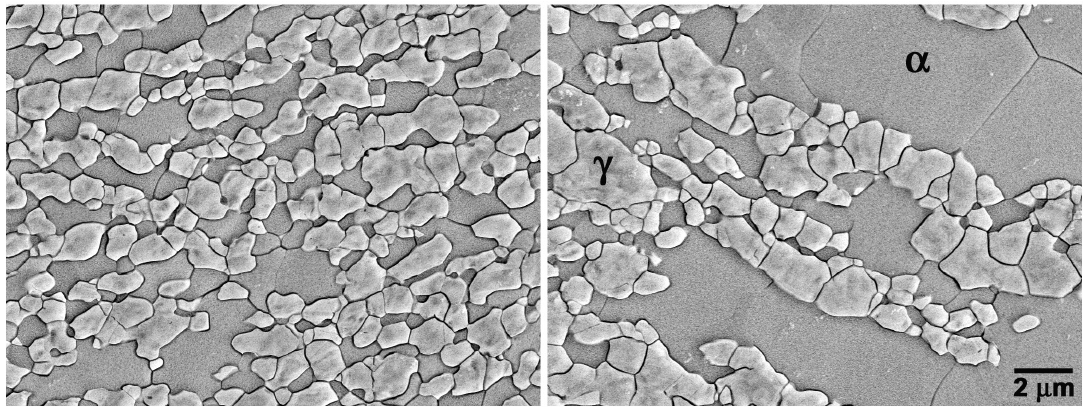
Fig. 9. Scanning electron microscopy (SEM) images of friction stir welded UNS S32750 SDSS: (a) SZ-RS and (b) SZ-AS.